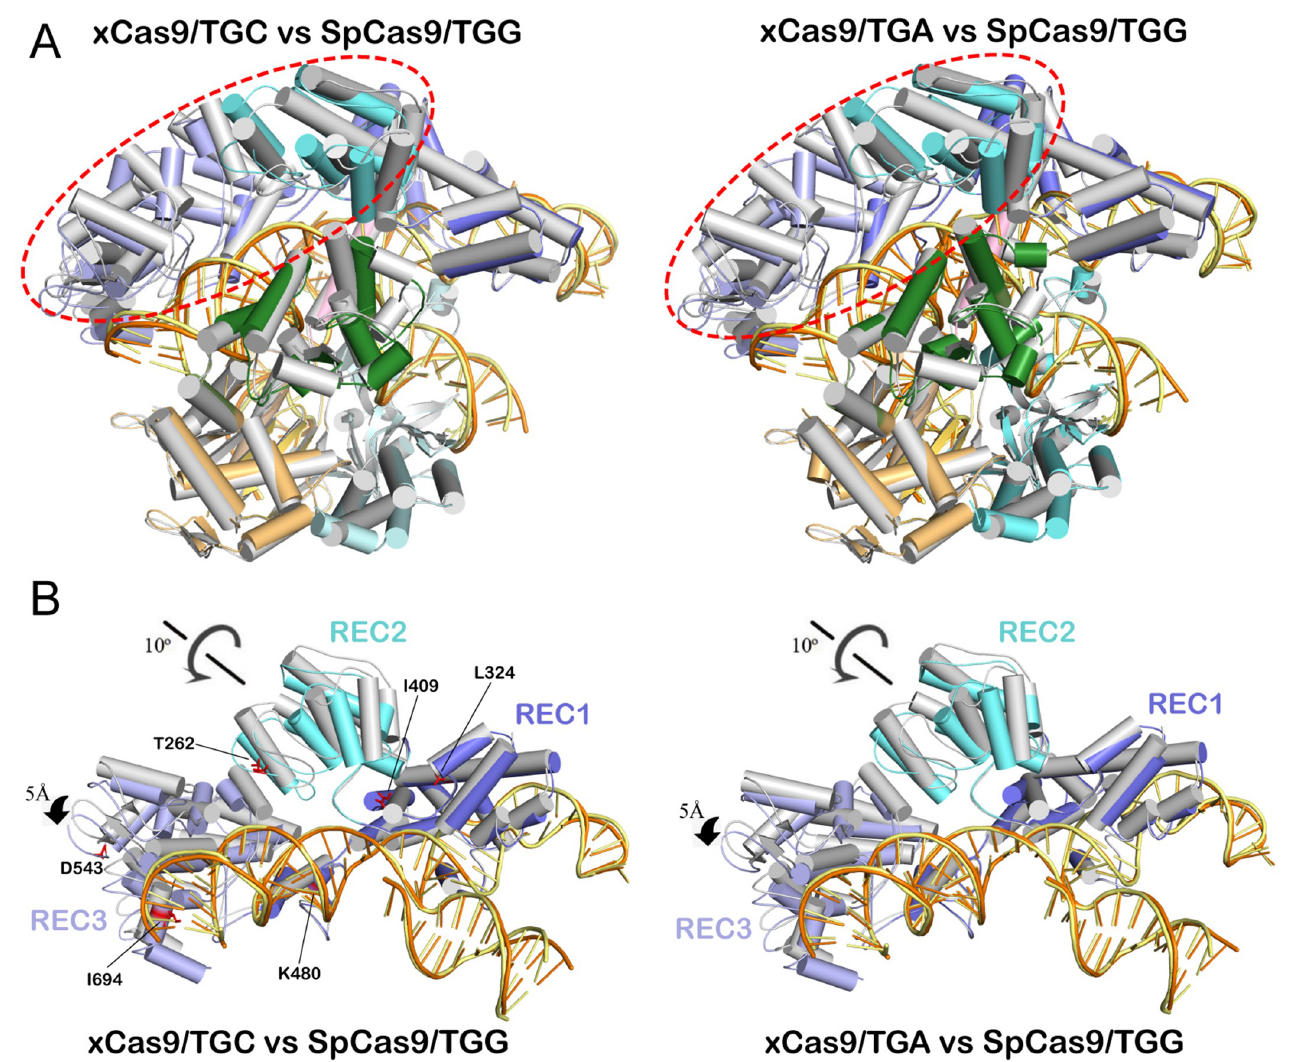
Fig 3. Structural comparison of xCas9 with WT SpCas9. (A) Overall structure superimposition of xCas9 and WT SpCas9 (PDB_ID: 4UN3). WT SpCas9 is colored white gray. Left panel: xCas9/TGC versus WT SpCas9; right panel: xCas9/TGA versus WT SpCas9. (B) Superimposition of the RNA/DNA heteroduplex- bound REC lobe of WT SpCas9 with that of xCas9 in complex with TGC (left) and TGA (right) PAMs. PAM, protospacer adjacent motif; REC lobe, α -helical recognition lobe; SpCas9, Streptococcus pyogenes Cas9; WT, wild-type.